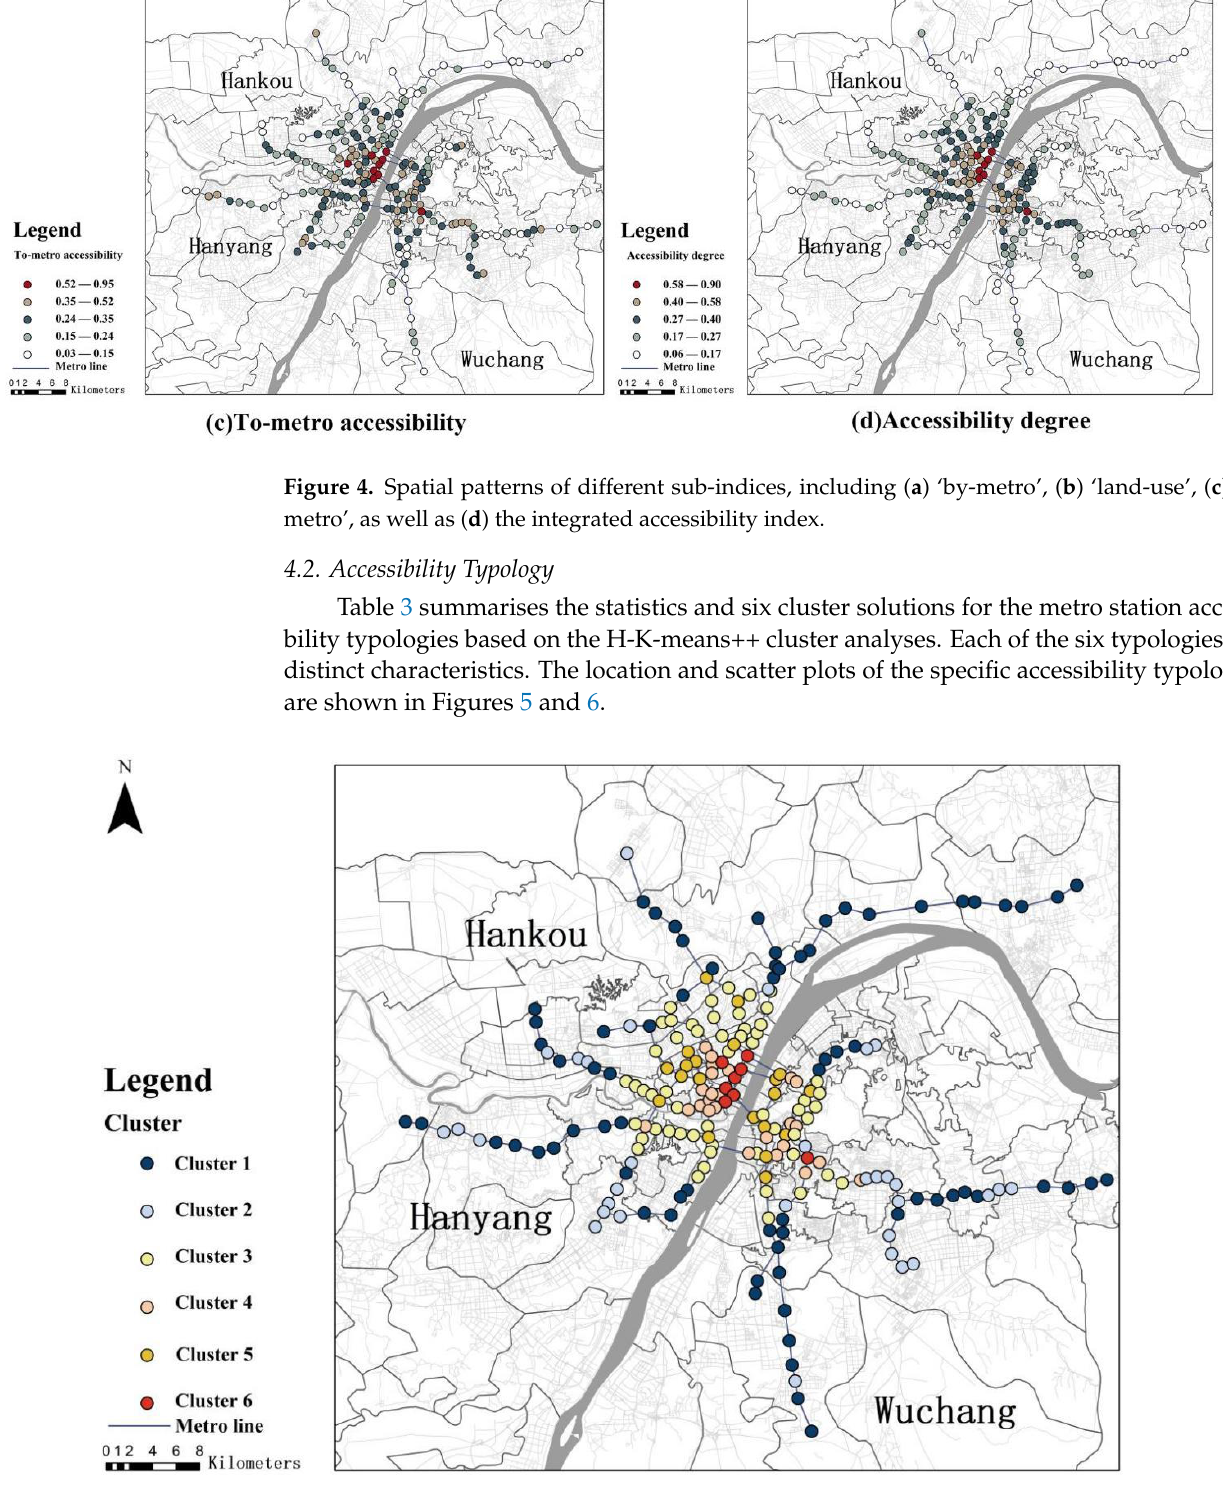
Figure 5. Classification of metro station accessibility in Wuhan.